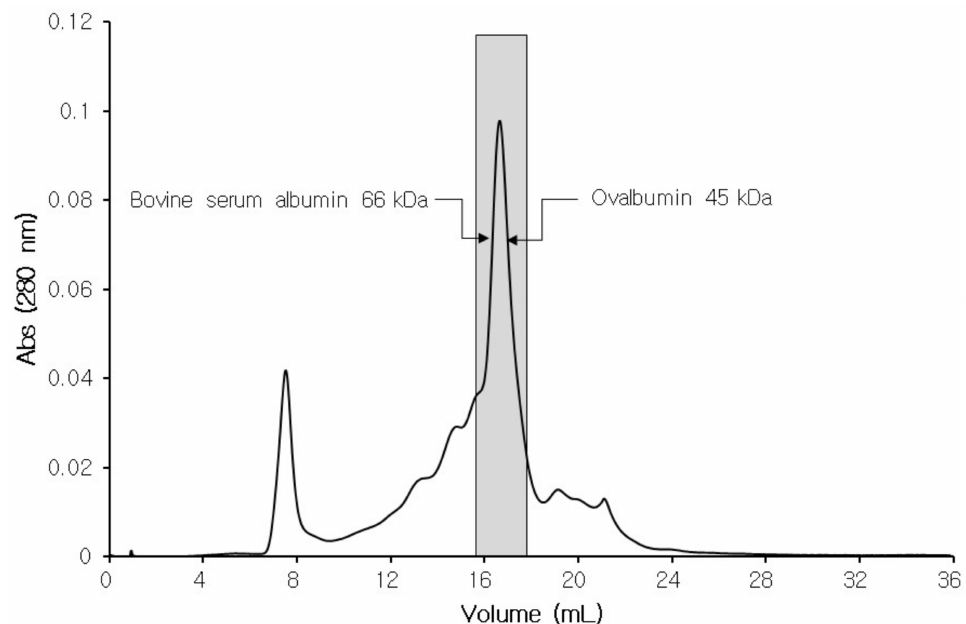
Figure 4. Fractions with CPI activity obtained from the affinity chromatography were pooled and subjected to gel filtration chromatography (Superose 6, FPLC). The peak in the bar area indicates fractions showing strong CPI activity, with molecular weights estimated between 45 and 66 kDa by comparing to results from standard proteins.